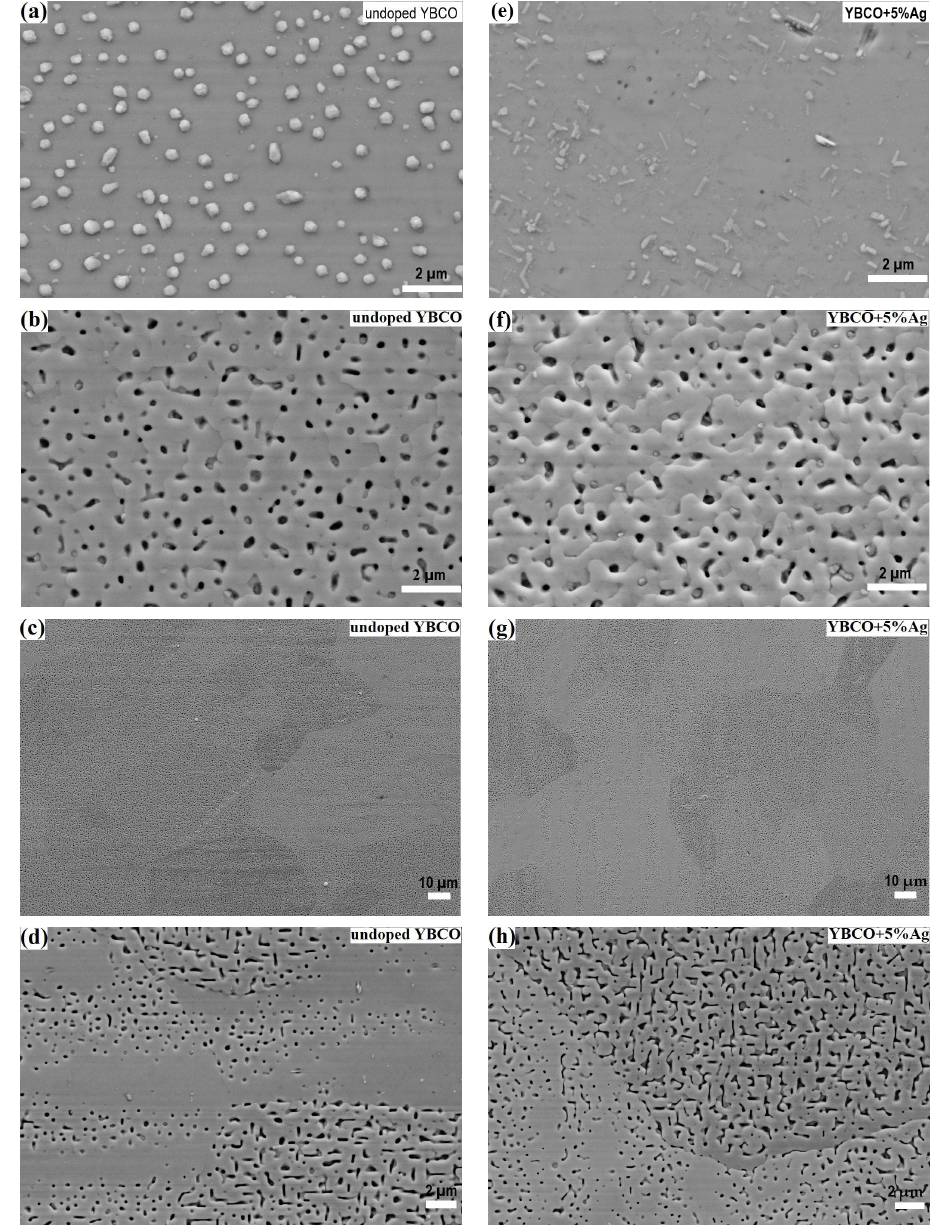
Figure 1. SEM images of the undoped and Ag−doped YBCO films on the ( a , e ) STO, ( b , f ) IBAD−MgO, and ( c , d , g , h ) RABiTS templates. and ( c , d , g , h ) RABiTS